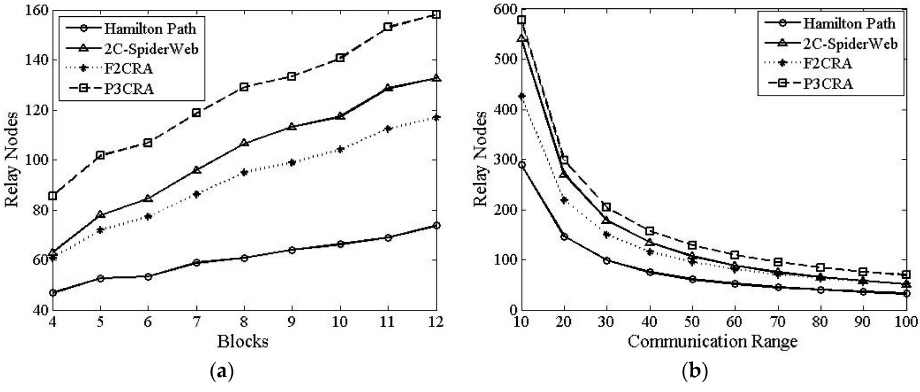
Figure 6. ( a ) Relay Nodes vs. Segments; and ( b ) Relay Nodes vs. Communication